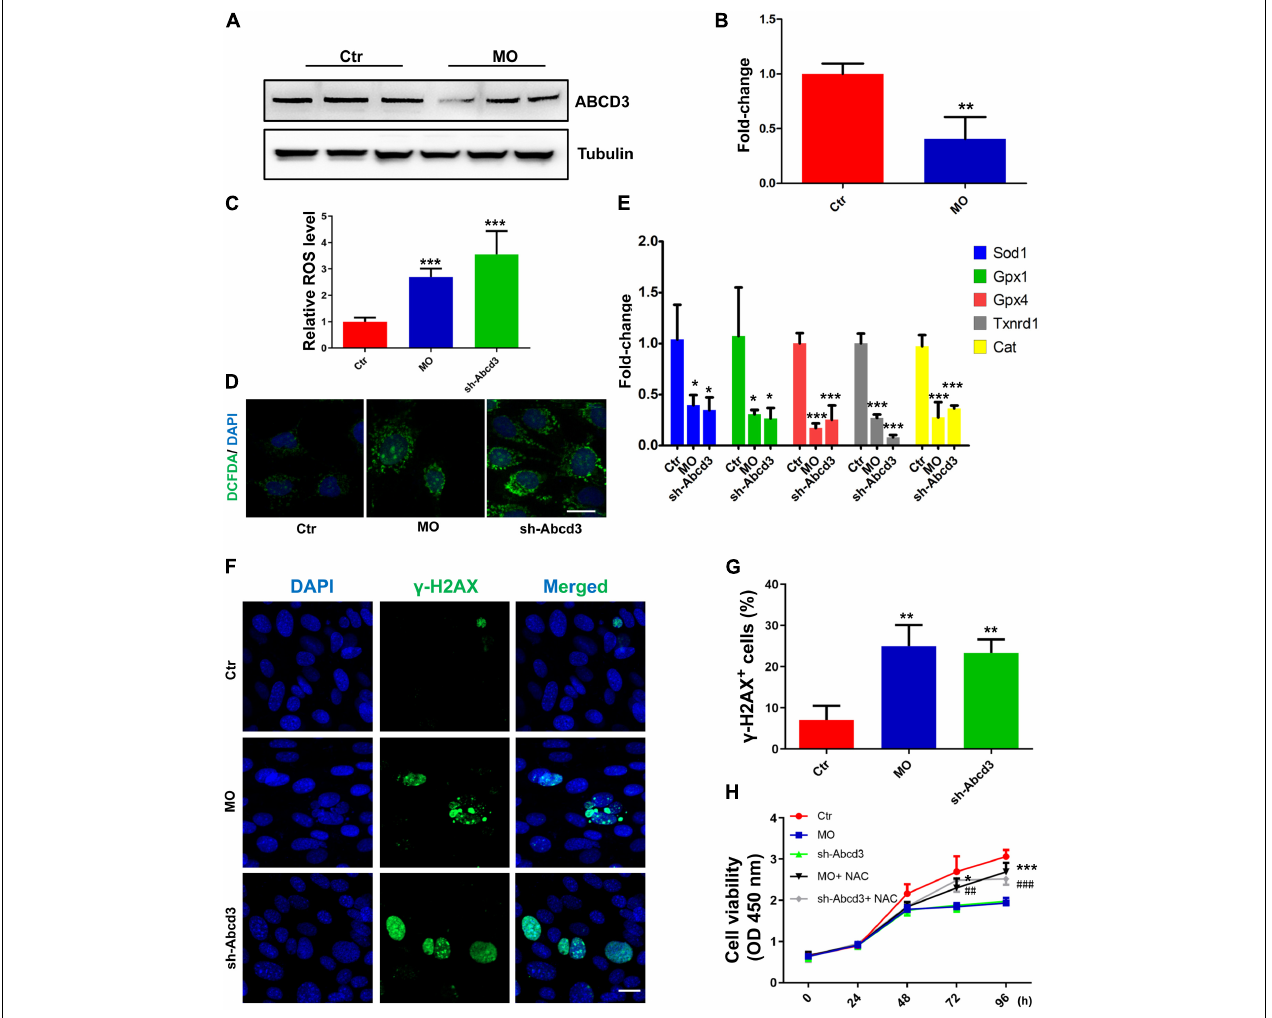
FIGURE 6 | Low levels of oxidative stress are potentially responsible for the INTS7–ABCD3 co-regulatory effects on BM-MSC proliferation and differentiation. (A) Western blot analysis of ABCD3 protein after the treatment with Ints7 -MO oligos or negative control MO for 48 h. Beta-tubulin protein was used as an internal control. (B) Quantification of ABCD3 protein levels in (A) , n = 3. (C,D) Levels of ROS in BM-MSCs treated with Ints7 -MO oligos or Abcd3 -shRNAs for 48 h, which were measured on a fluorescent plate reader (C) or a confocal laser-scanning microscope (D) , n = 6. (E) The mRNA levels of several endogenous antioxidants were detected by QRT-PCR after INTS7 or ABCD3 inhibition for 48 h, n = 3. (F) Immunostaining of γ -H2AX in BM-MSCs treated with Ints7 -MO oligos or Abcd3 -shRNAs for 48 h. The γ -H2AX–positive cells are labeled in green, and cell nuclei are labeled in blue. (G) Quantification of γ -H2AX–positive cells in (F) , n = 3. (H) CCK-8 assays were used to determine the proliferative capacity of BM-MSCs treated as indicated. N-acetylcysteine (NAC) was used at the concentration of 500 µ M. *, compared with Ints7 -MO; # , compared with Abcd3 -shRNAs, n = 6. Scale bar, 20 µ m, * p < 0.05; ** p < 0.01; *** p < 0.001, ## p < 0.01; ### p < 0.001. For (B)